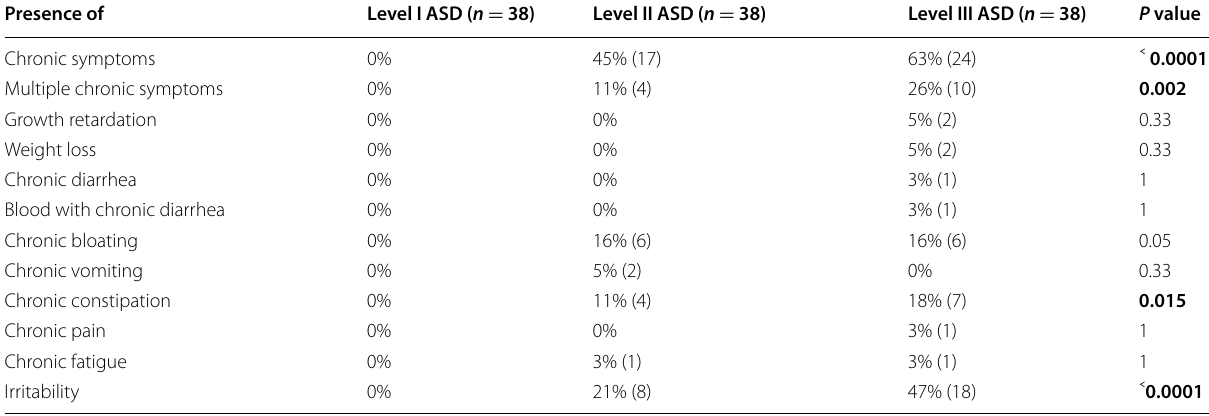
Table 6 Description and comparison of the chronic symptoms among the three groups in the study